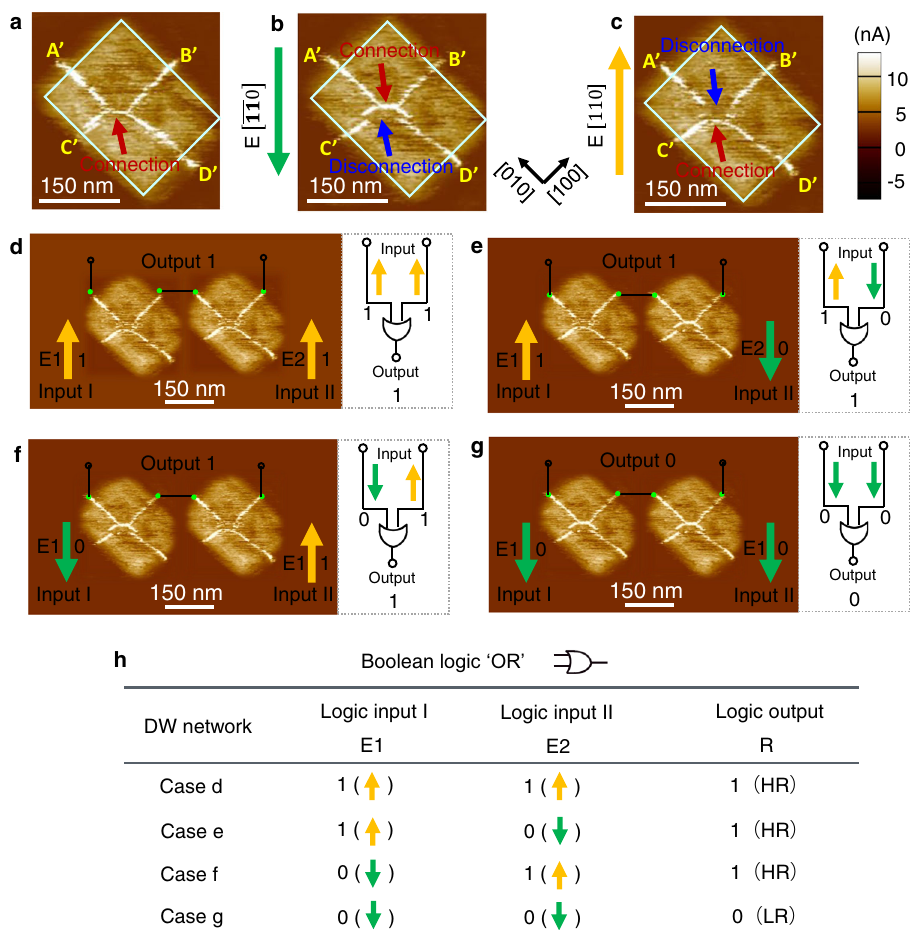
Fig. 4 Recon fi gurable OR logic gate. a – c CDW networks at the initial state and controlled by an in-plane trailing fi eld in a BiFeO 3 nano-island with an AR of 1.25. The connection/disconnection of A 0 / B 0 node and disconnection/connection of C 0 / D 0 node is implemented concurrently in one nano-island by applying an in-plane fi eld along [ (cid:1) 1 (cid:1) 10] ( b ) or [110] direction ( c ). d – g c-AFM images and corresponding logic circuit diagrams of two series-connected nano-islands with the sequence of logic operations for inputs of ‘ 11 ’ , ‘ 10 ’ , ‘ 01 ’ , and ‘ 00 ’ . h Truth table for OR logic gate respectively. E1 and E2 are the applied in-plane trailing fi elds for the two nano-islands. R represents the resistance of the DW between the output electrodes.